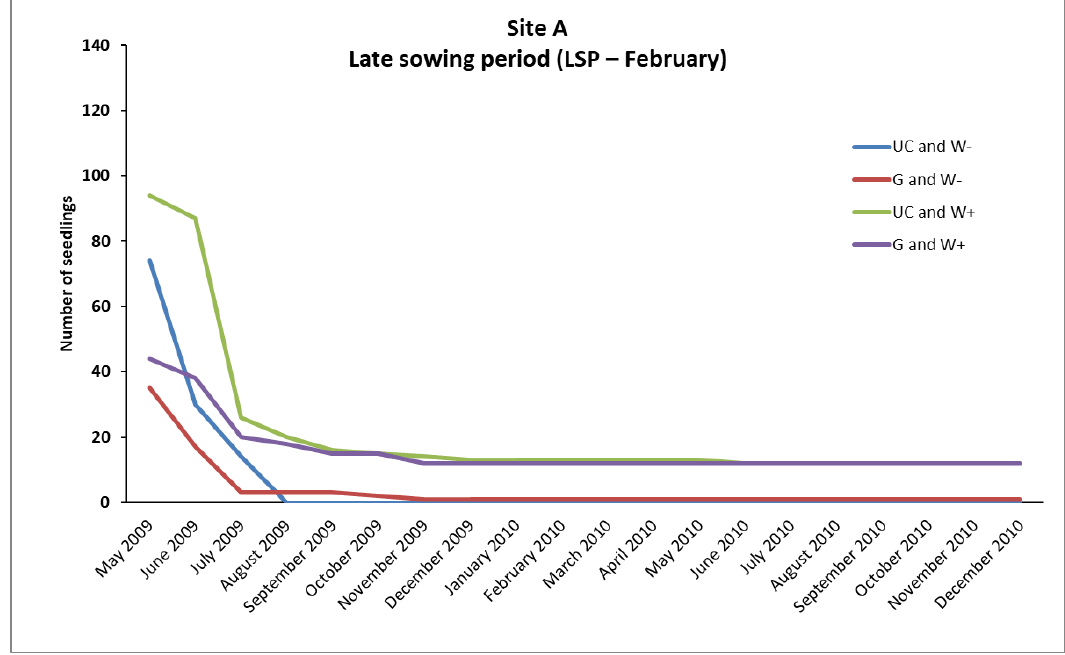
Figure 2. Monthly seedling survival (number of living seedlings) of the February sowing (LSP) in the plots of each combination of the two factor levels in site A for the period May 2009–December 2010 (the May 2009 record shows the number of germinated seeds).